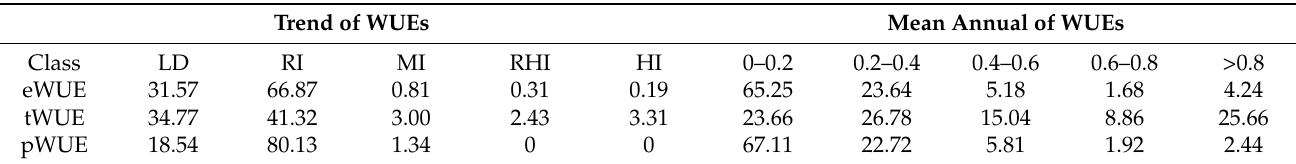
Table 2. Trend change and mean annual of WUEs percentage (units: